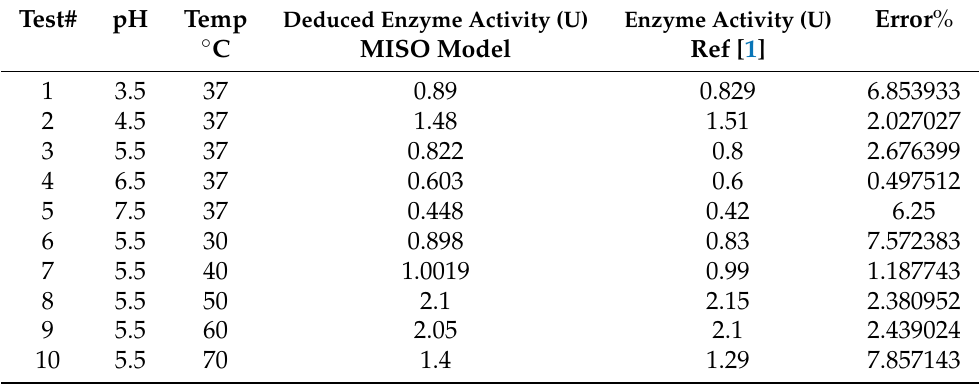
Figure 11. Performance of SISO pH–enzyme activity FIS model. (U = µ mol/min). The validity of the proposed MISO model response was investigated for two simul- taneous inputs (pH and temperature), using two sets of testing points: The first group of points is set at 37 °C at varying pH values, while the second group of data points is set at a constant pH value (pH 5.5) at varying temperatures. The results are compared with equivalent points interpolated from the experimental results in Ref [1] for identical experimental conditions. The results for the selected input values are listed in Table 2. Table 2. Performance of pH–temp–enzyme activity model performance at testing points. (U = µ